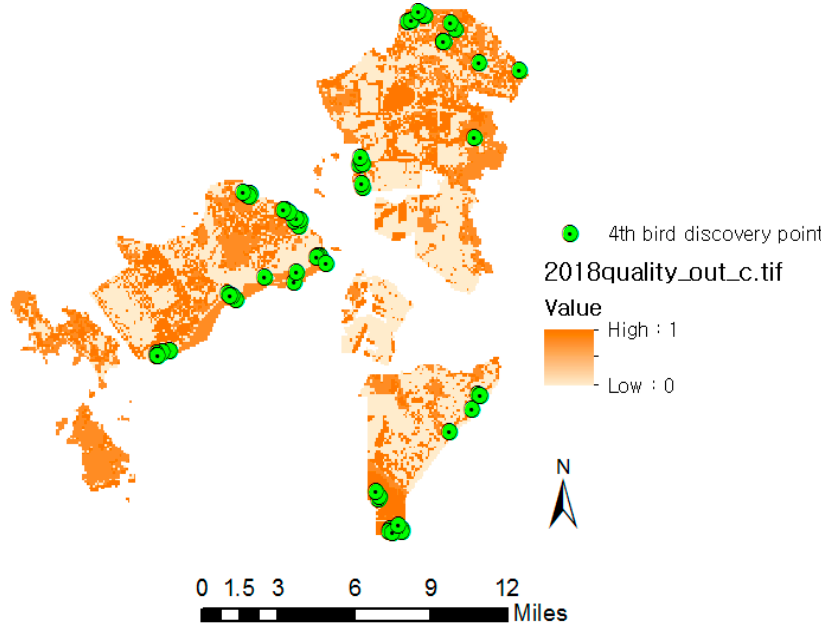
Figure 6. Overlapping maps of bird spotting points and 2018 habitat quality.